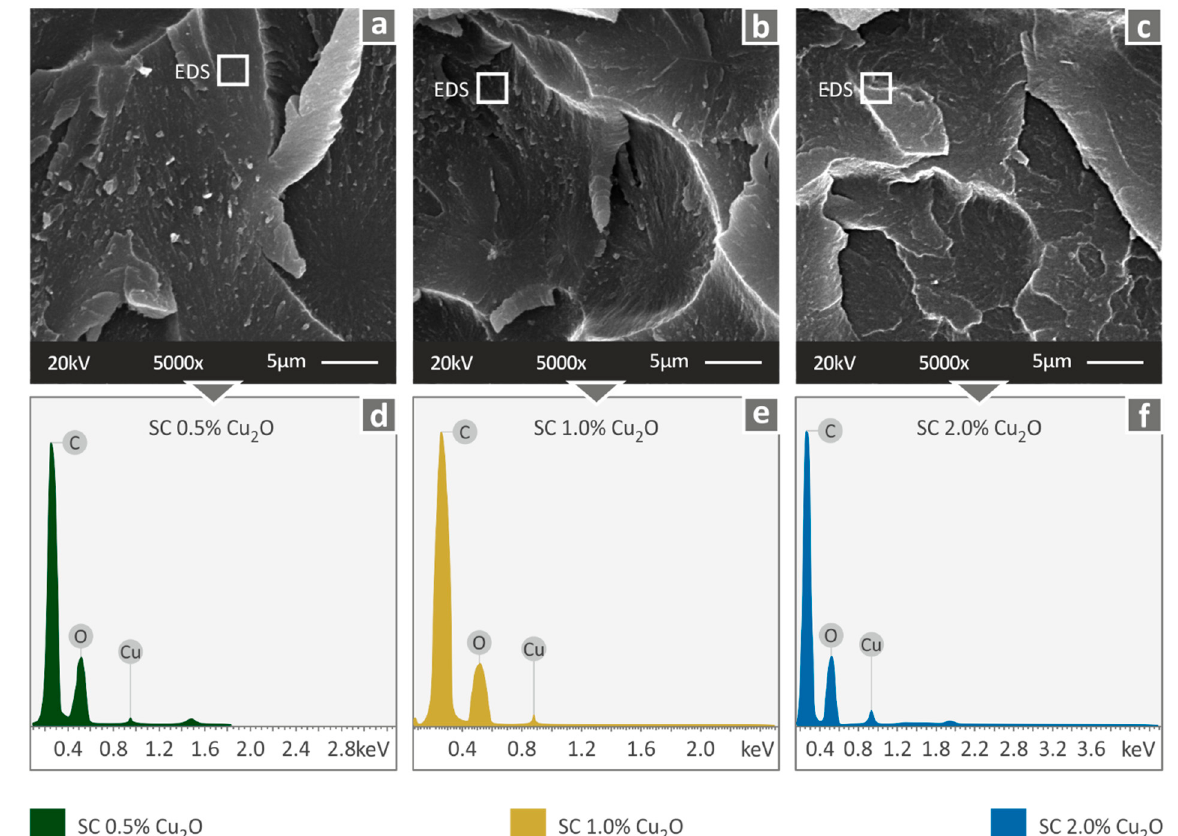
Figure 7. Fracture area high magnification captures at 5000× level and the corresponding EDS anal- ysis results: ( a ) SC Cu2O 0.5 wt.% SEM 5000×, ( b ) SC Cu2O 1.0 wt.% SEM 5000× ( c ) SC Cu2O 2.0 analysis results: ( a ) SC Cu 2 O 0.5 wt.% SEM 5000 × , ( b ) SC Cu 2 O 1.0 wt.% SEM 5000 × ( c ) SC Cu 2 O wt.% SEM 5000× ( d ) SC Cu2O 0.5 wt.% EDS graph ( e ) SC Cu2O 1.0 wt.% EDS graph, ( f ) SC Cu2O 2.0 wt.% SEM 5000 × ( d ) SC Cu 2 O 0.5 wt.% EDS graph ( e ) SC Cu 2 O 1.0 wt.% EDS graph, ( f ) SC Cu 2 O 2.0 wt.% EDS graph. 2.0 wt.% EDS graph.